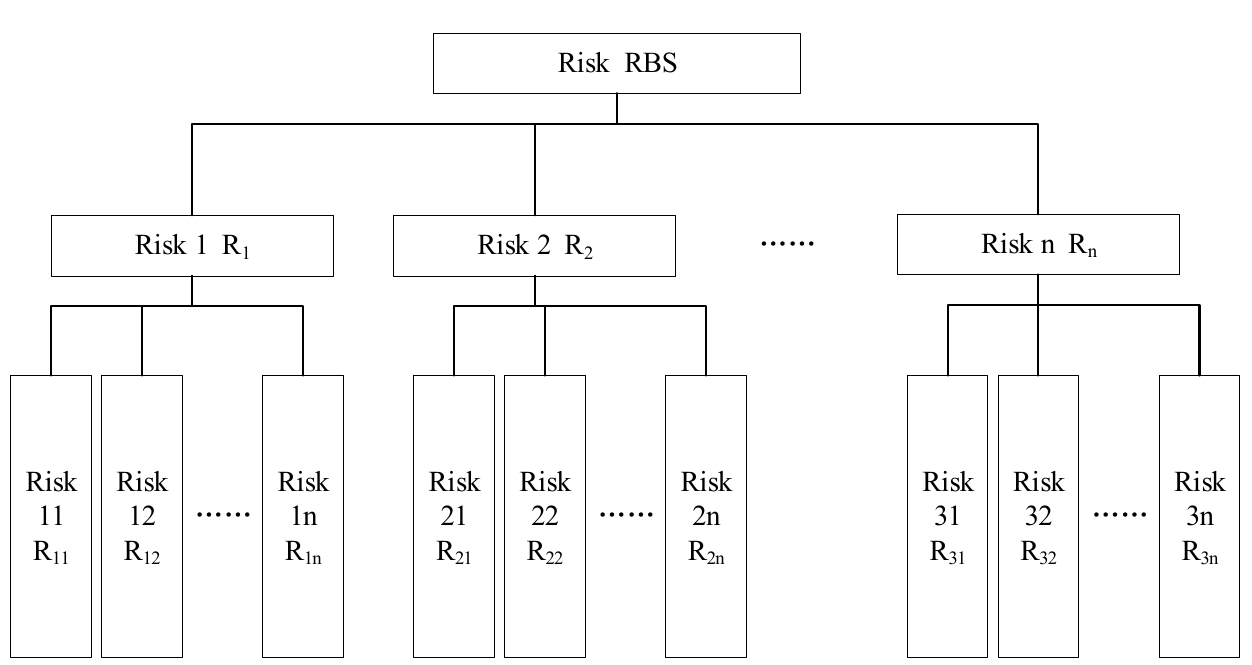
Figure 4. RBS structure example diagram. Through the analysis of combining the WBS breakdown and RBS breakdown of the project, a WBS-RBS cross-coupling matrix can be formed with the unit operation formed by WBS breakdown as the column and the sub-risks breakdown by RBS as the row. As shown in Figure 5, the point where the row and column intersect in the matrix is the possible risk in the operation process, where the number 1 indicates the existence of cross risk and the number 0 indicates the possibility of no cross risk [27].